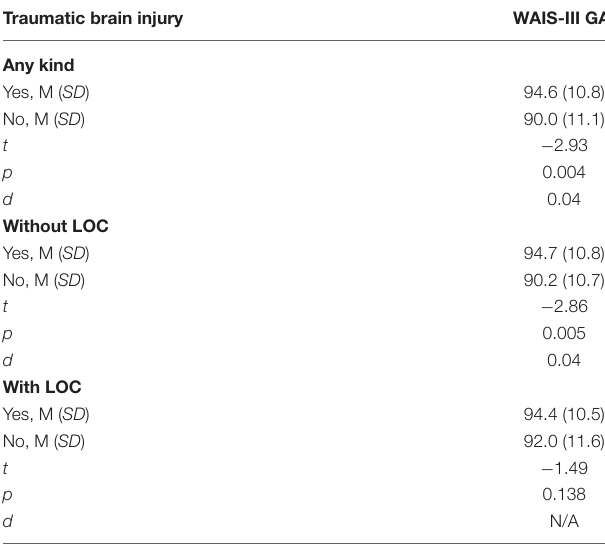
TABLE 4 | Associations (Student’s t -test) between traumatic brain injury and intellectual